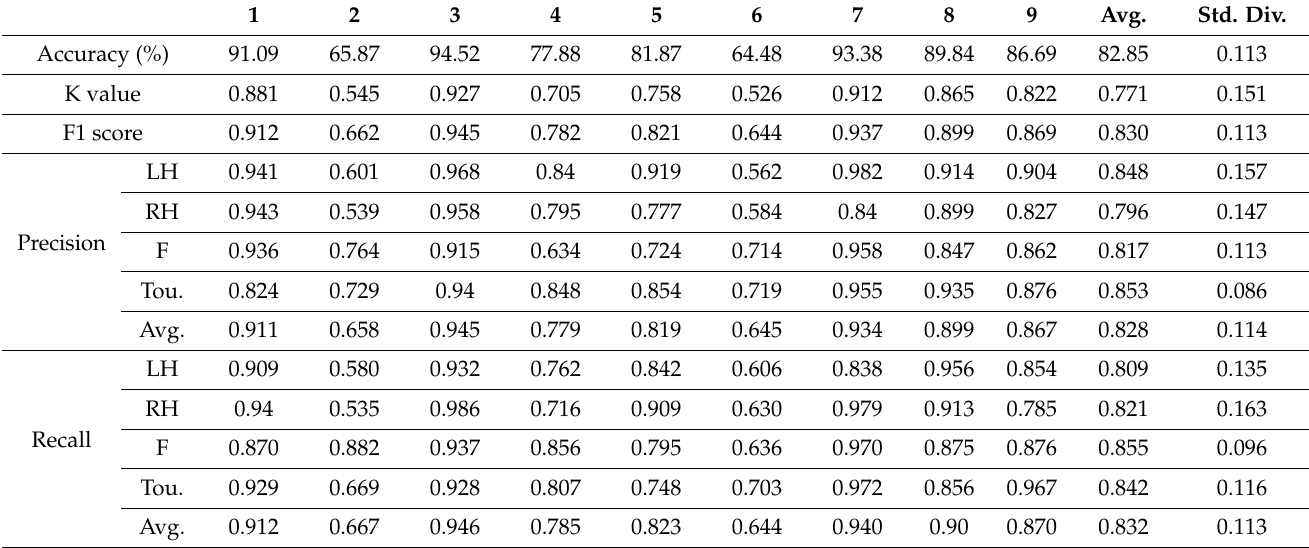
Table 4. Performance metrics on the BCI-IV2a dataset using the MBEEGCBAM.